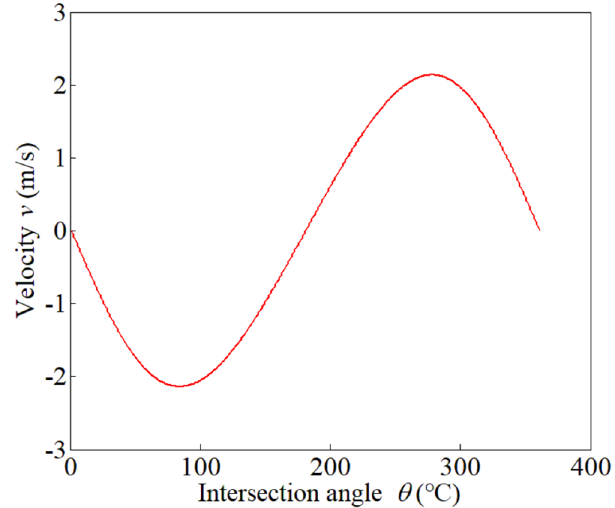
Fig. 5. Velocity of slider in a circle.